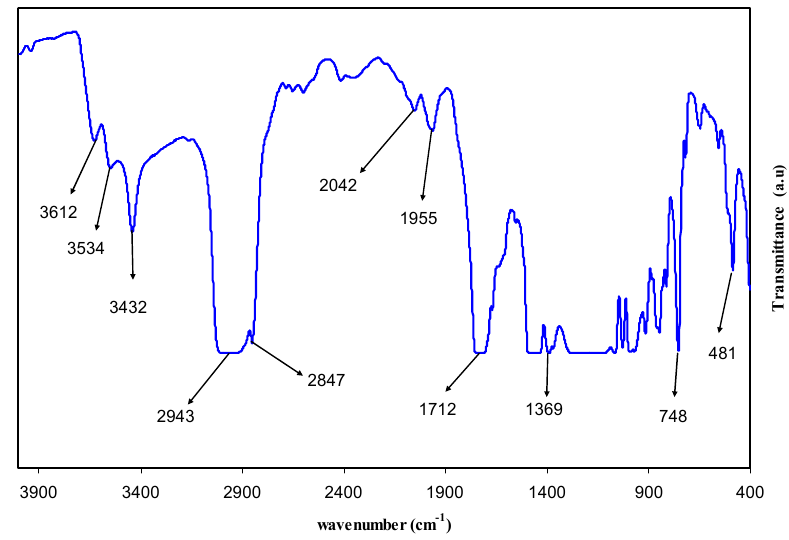
Figure 4. FTIR spectra of dye doped PMMA polymer (GT 28). Shifting of peaks and their broadening is evidence for the complex formation between the extract GT solution and PMMA polymer.